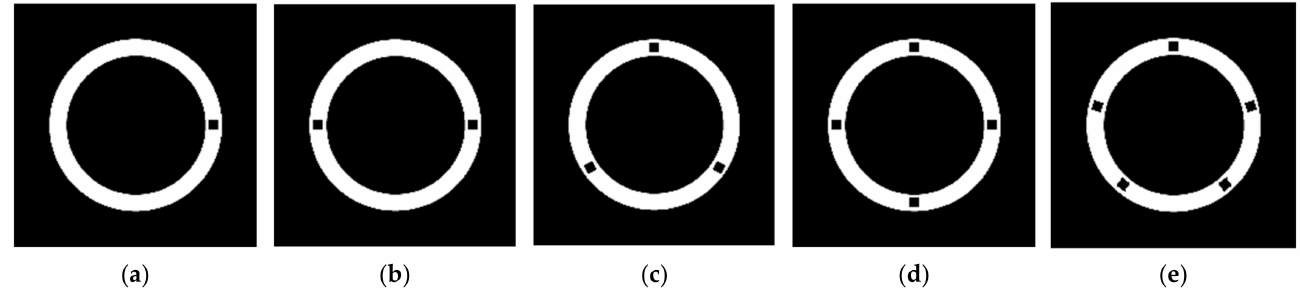
Figure 6. Modified CT images for different quantities of simulated microchannel with square shape and cross-sectional area of 64 pixel 2 (0.2273 mm 2 ). ( a – e ): microchannel quantity = 1, 2, 3, 4, 5.